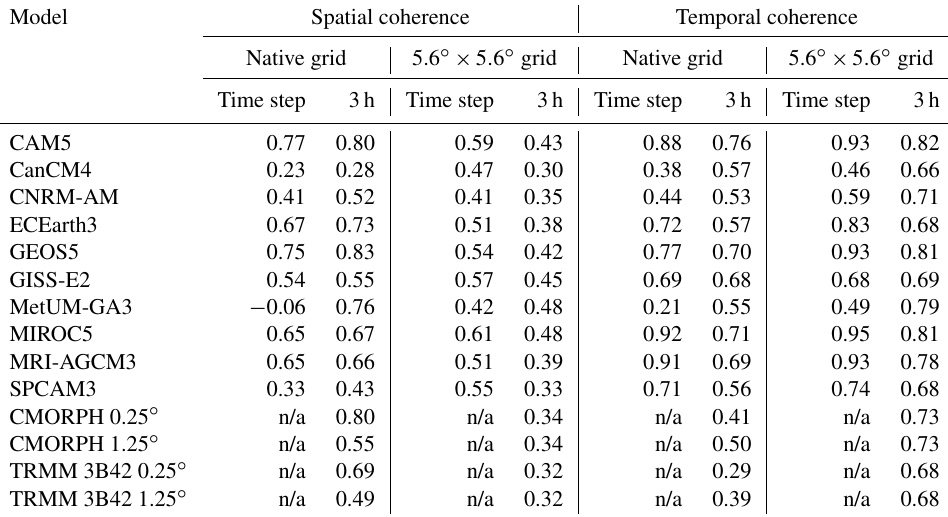
Table 3. For each model, as well as TRMM 3B42 and CMORPH: summary metrics of spatial and temporal coherence in precipitation, using time step and 3h data on the native horizontal grid and interpolated to a common 5.6 ◦ × 5 . 6 ◦ horizontal grid. Positive values indicate that coherence is more common than intermittency; negative values indicate that intermittency is more common than coherence. Higher magnitudes indicate stronger coherence or intermittency for positive or negative values, respectively. The time step column is marked “n/a” for TRMM and CMORPH because these datasets exist only as 3h values. By definition, the 5.6 ◦ × 5 . 6 ◦ values are identical for the TRMM 0.25 and 1.25 ◦ datasets, as well as for the CMORPH 0.25 and 1.25 ◦